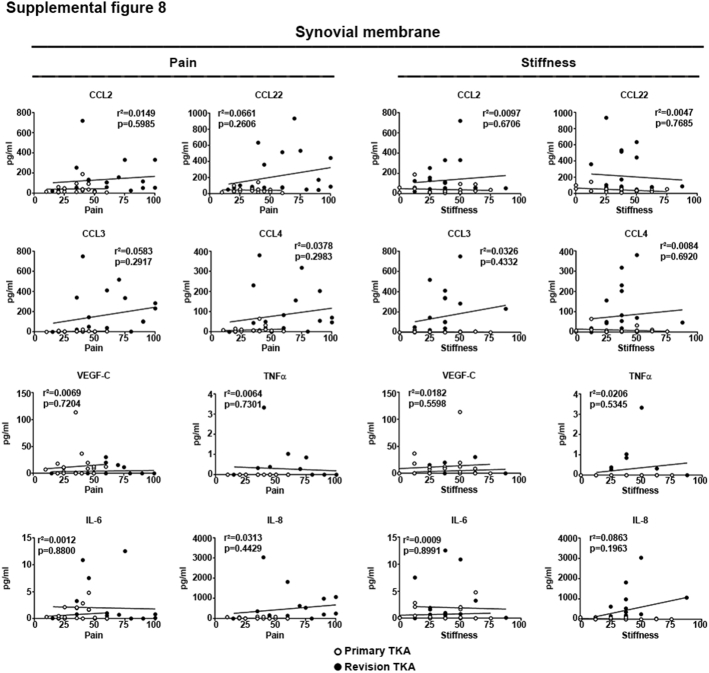
Pain and stiffness are poorly correlated to inflammatory markers in synovial membrane. Pain and stiffness, as determined by Western Ontario and McMaster Universities Osteoarthritis Index scores, were plotted against expression levels of several markers that were significantly elevated in patients undergoing revision total knee arthroplasty (TKA). Data are presented for patients undergoing primary and revision TKA, and correlations were determined by linear regression analysis. n = 20 primary TKA group; n = 21 revision TKA group. TNF, tumor necrosis factor; VEGF, vascular endothelial growth factor.